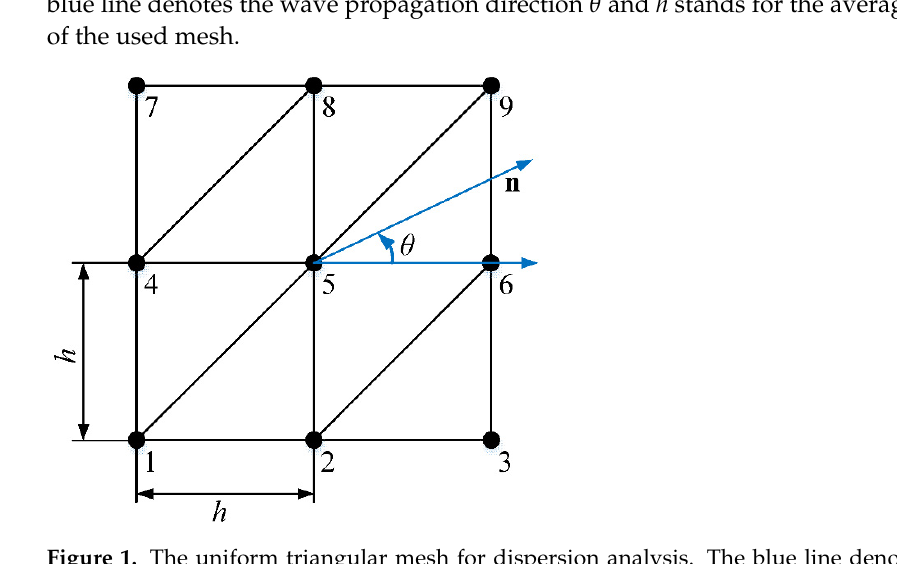
Figure 1. The uniform triangular mesh for dispersion analysis. The blue line denotes the wave propagation direction.